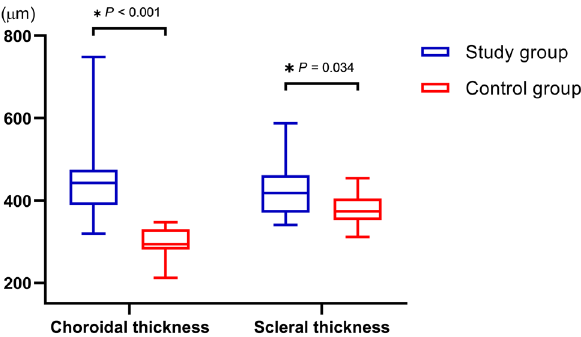
Figure 1. Box plot images showing the difference in choroidal thickness and scleral thickness between study and control groups. Upper and lower bars represent maximum and minimum values,